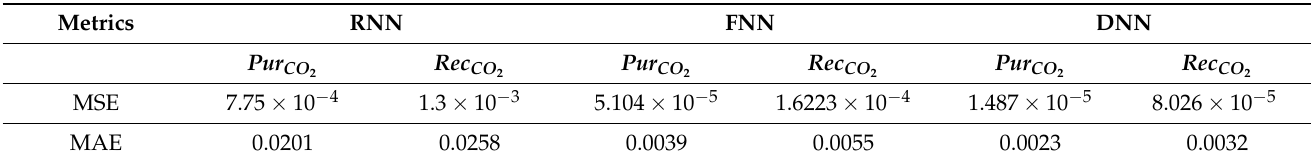
Table 3. Models’ test performance